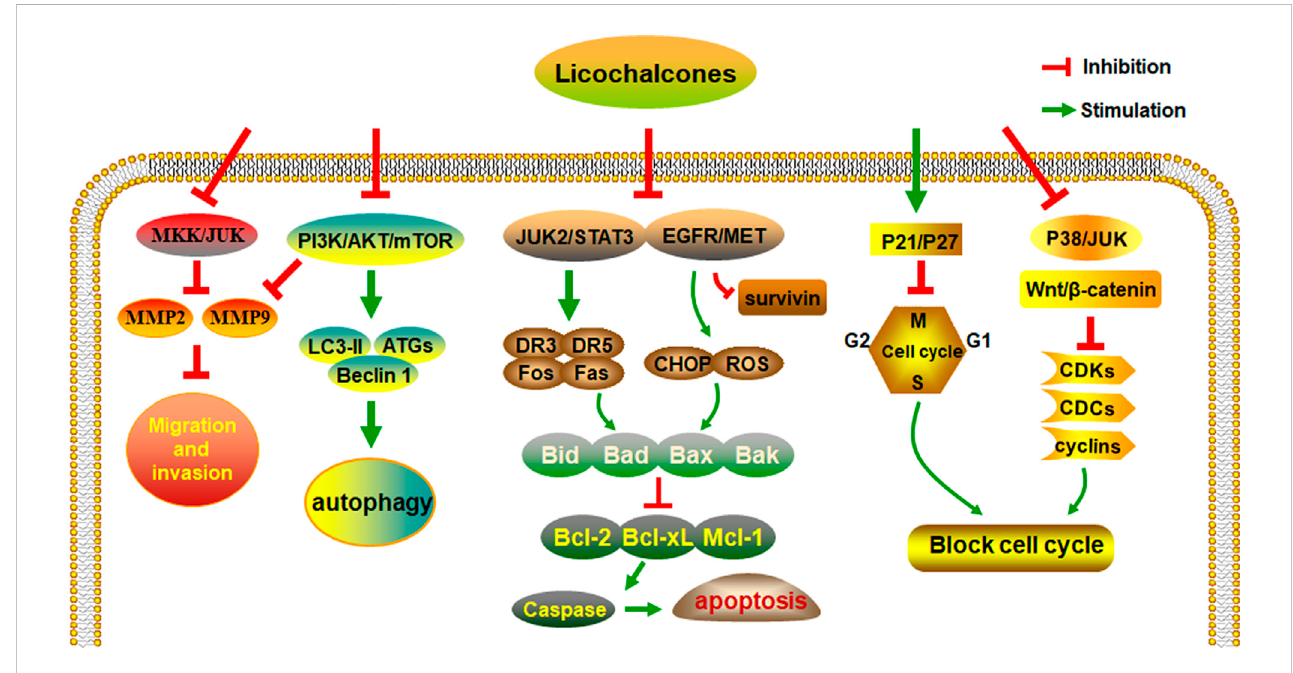
FIGURE 2 The anti-cancer activities and molecular mechanisms of